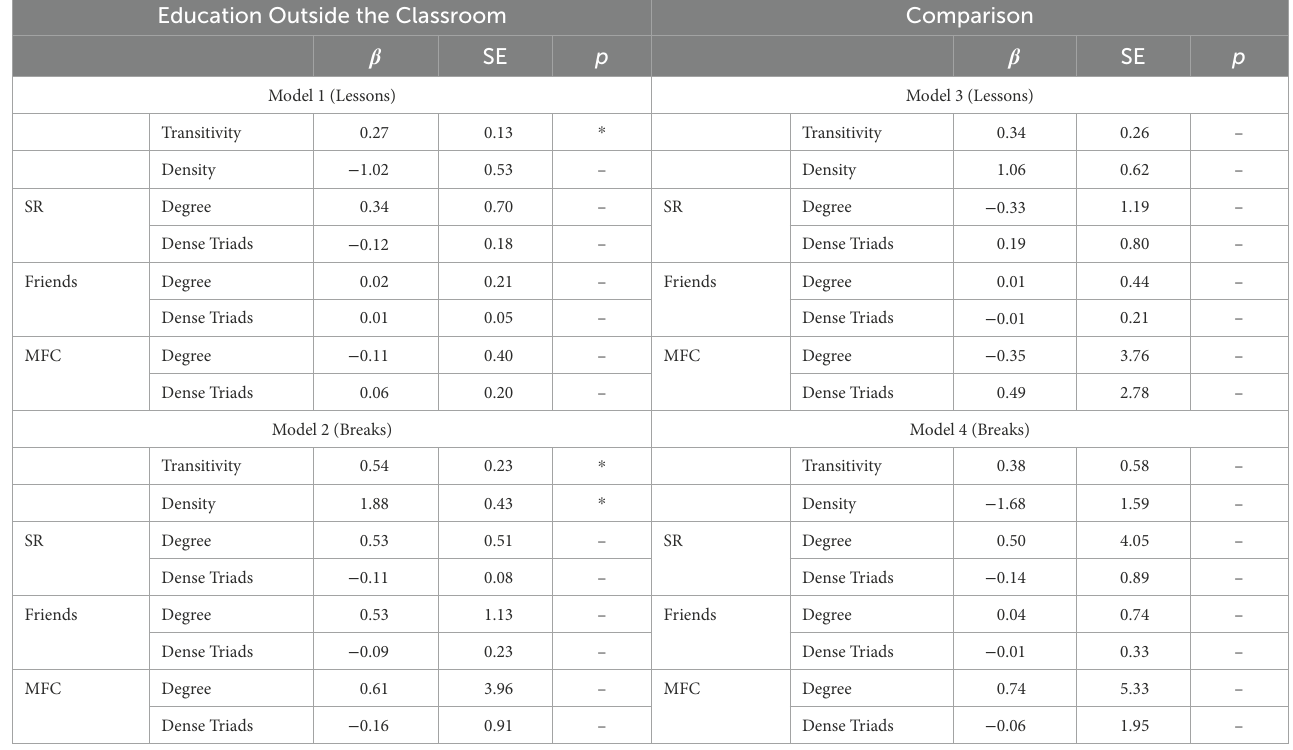
TABLE 4 Results of testing for structural effects and co-evolutional associations over